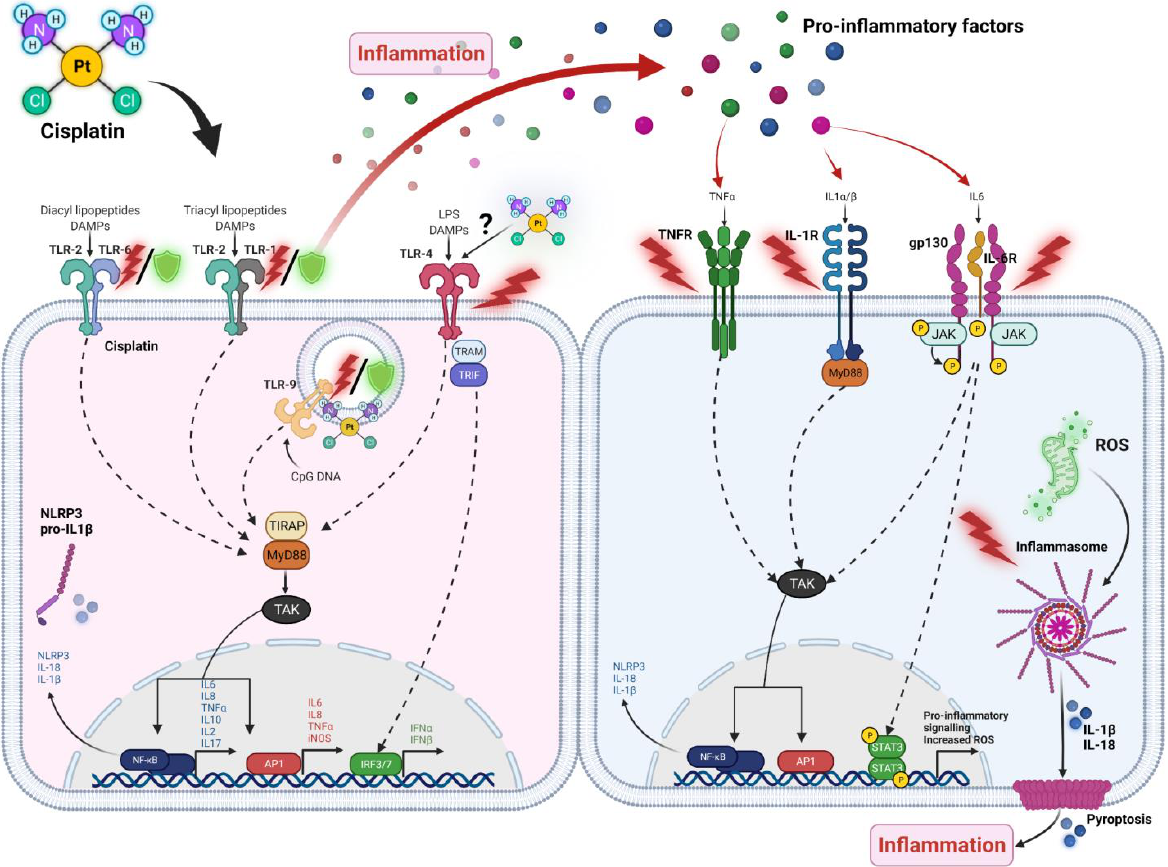
Figure 2. Pattern recognition receptors and pro-inflammatory signalling pathways involved in cisplatin-induced toxicities. Pattern Recognition Receptors interact with a specific array of PAMPs and DAMPs to mediate signals that induce pro-inflammatory signalling. Most of these pathways share downstream signalling that converge on NF- κ B, AP-1, or IRF3, which regulate expression of pro-inflammatory signalling molecules such as cytokines and chemokines to influence inflammation in surrounding cells. These molecules bind receptors like TNF-R and IL6-R in other cells that mediate similar signalling pathways. This localised inflammation is exacerbated by cisplatin treatment and is involved in various CITs through mechanisms that remain to be elucidated.